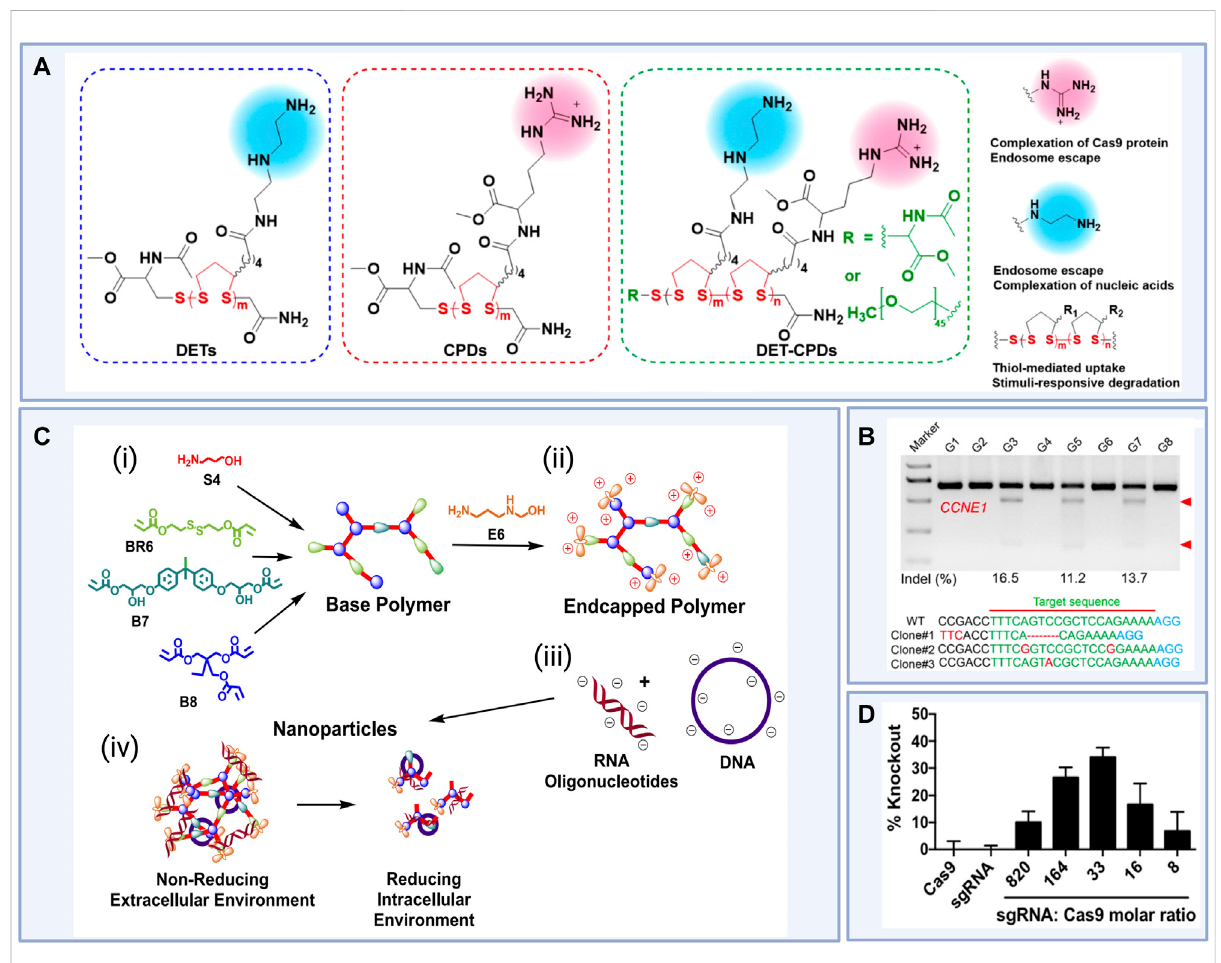
FIGURE 5 (i) Rational design of novel diethylenetriamine cell-penetrating poly (disul fi de)s (DET-CPDs) for use in nanoparticle-based gene delivery and (ii) in vivo indel frequencies detected by the T7E1 assay from murine liver tissue and representative Sanger sequencing results of T-A cloning from liver tissue after treatments (Clone 1, DET-CPD-12/CMV-Cas9-sgCCNE1; Clone 2, DET-CPD-12/Cas9 mRNA sgCCNE1; Clone 3, DET-CPD-12/ Cas9 RNP-sgCCNE1) where DET-CPD-12 was the top-performing poly (disul fi de) DET-CPD and G3, G5, and G7 represent Clones 1, 2, and 3 respectively. G1 and G2 represent phosphate buffered saline (PBS) controls and G4, G6, and G8 represent mock gRNA treatments. (iii) Design of R6,7,8_64, a novel reducible branched poly (amino ester) (rPBAE) for use in nanoparticle-based gene delivery and (iv) percent green fl uorescent protein (GFP) knockout in HEK 293Ts stably expressing GFP induced For example, in vitro gene editing ef fi ciencies achieved via R6,7,8_64 particle- mediated delivery of Cas9 plasmid constructs and anti-GFP sgRNA at a variety of sgRNA to Cas9 molar ratios compared to R6,7,8_64 particle- mediateddeliveryofCas9orsgRNAalone. Figure 5(i) and(ii) reusedfromGuo etal.,2021withpermission fromAmerican Chemical Society. License CC BY-NC-ND 4.0 https://creativecommons.org/licenses/by-nc-nd/4.0/. Figure 5 (iii) and (iv) reprinted with permission from (Rui et al.,